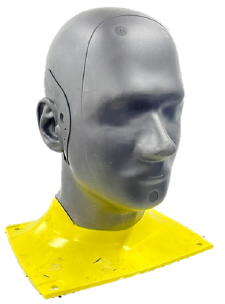
Figure 6. POPEYE-V10 [35].